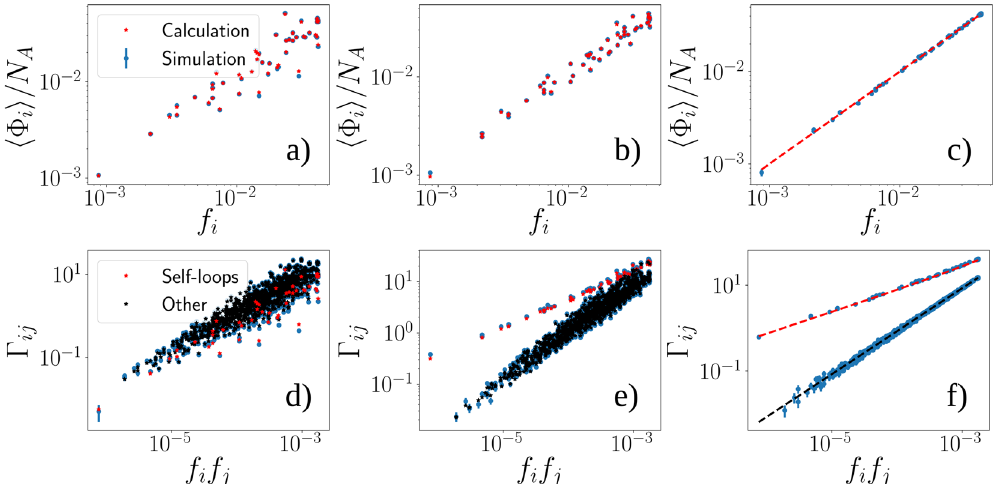
Figure 3. Simulation results and analytic results for the outcomes of the model. q = 0 ( a,d ), q = 0.5 ( b,e ) and q = 1 ( c,f ). Realized populations in the top row and weights in the bottom row. Here G A corresponds to an Erdös-Reny (ER) random graph of size N A = 10 3 with edge probability of p = 10 − 2 . We generate 1000 network realizations from the ER model and assign them to the target nodes of network B, which here corresponds to a 50-node network that are randomly scattered on a 2-dimensional square and are linked by their spatial adjacency based on a Voronoi tessellation. Results shown are an average over the 1000 independent realizations of the networks. The attractiveness of nodes f in G B are sampled from a uniform (1, 100) distribution and then rescaled to satisfy the constraint ∑ = . The simulated values are shown in blue while the stars are the f 1 iN = i 1 B results of the calculations. In the bottom row ( d–f ) red stars stand for the weights of the self-loops in the embedded network and black stars for the other edges. Note how the self-loops gain more weight as compared to the rest of edges as q is greater, reflecting the more localized structure of the embedding. In the case q = 1 ( c , d ), the expression for the realized populations and for the weights of the embedded network are simple functions of attractiveness and therefore we show them as